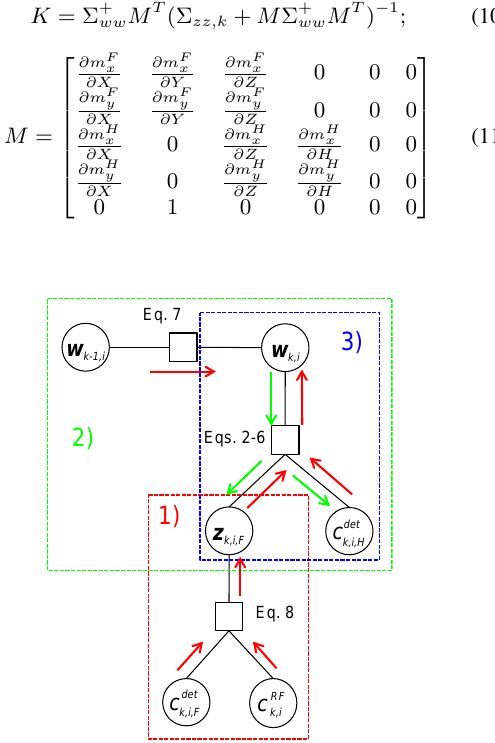
Figure 2. Factor graph representation of the DBN.